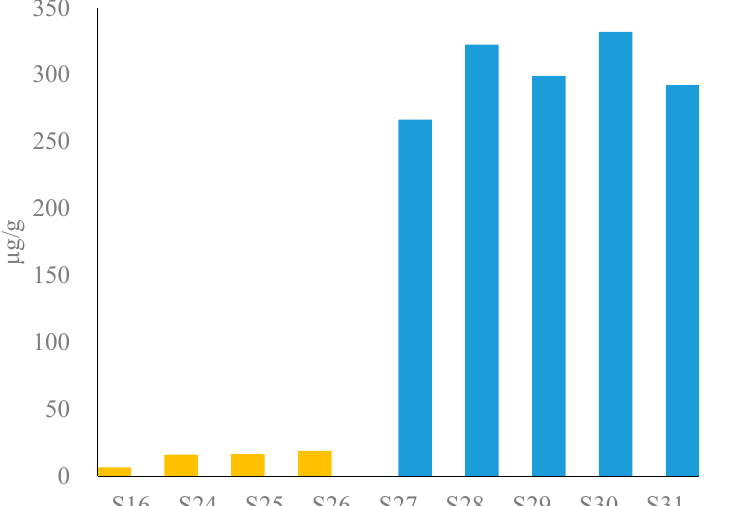
Figure 3. Bar graph of content of total alkaloids in fresh Houttuyniae herba.